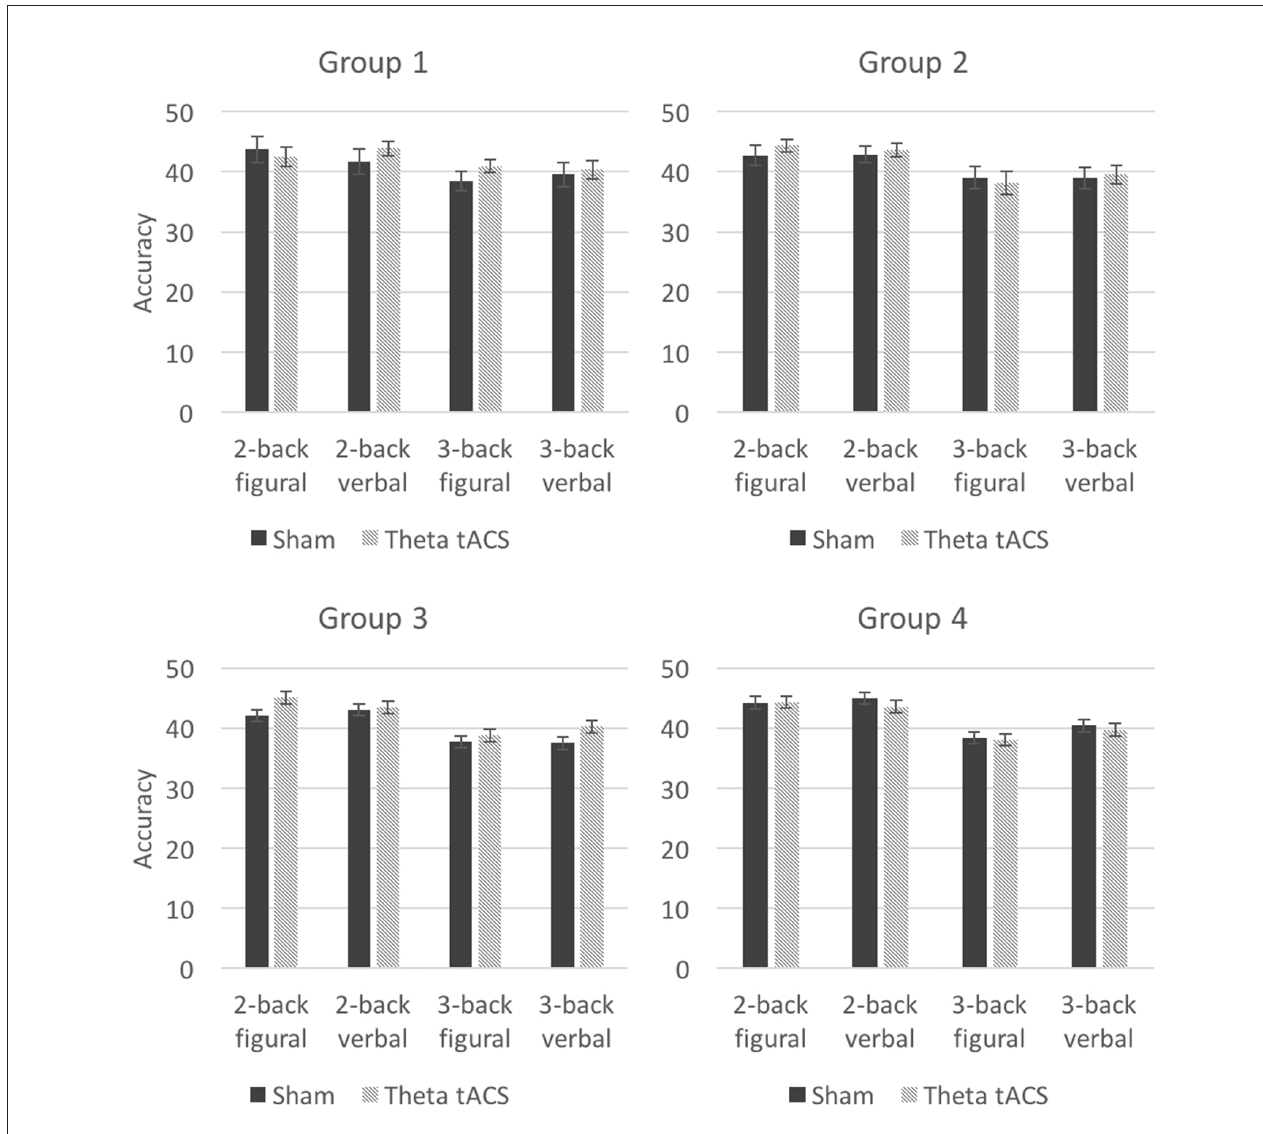
FIGURE 3 | Average n-back accuracy in theta tACS and sham sessions in the four groups. Error bars represent